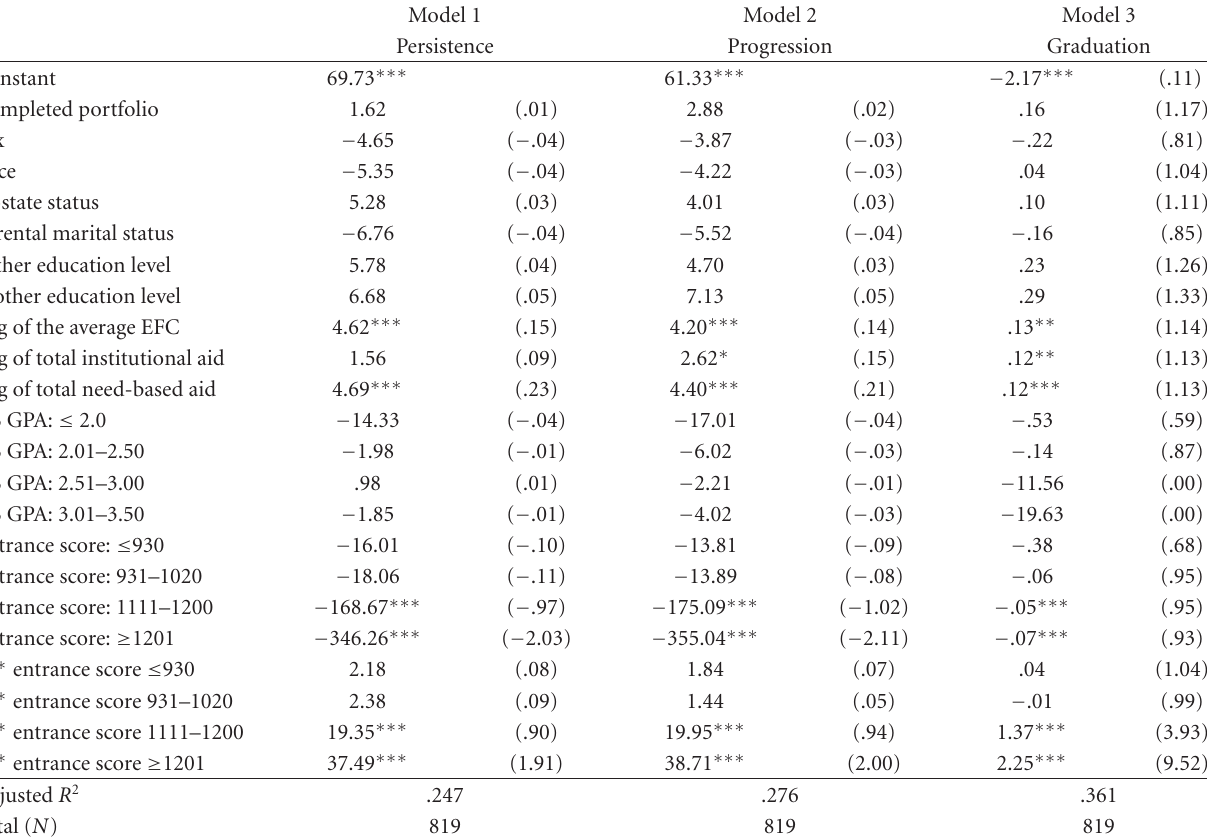
Table 2: OLS and logistic regression of independent, control, and entrance test score interaction variables on persistence (Model 1: OLS), progression (Model 2: OLS), and graduation (Model 3: